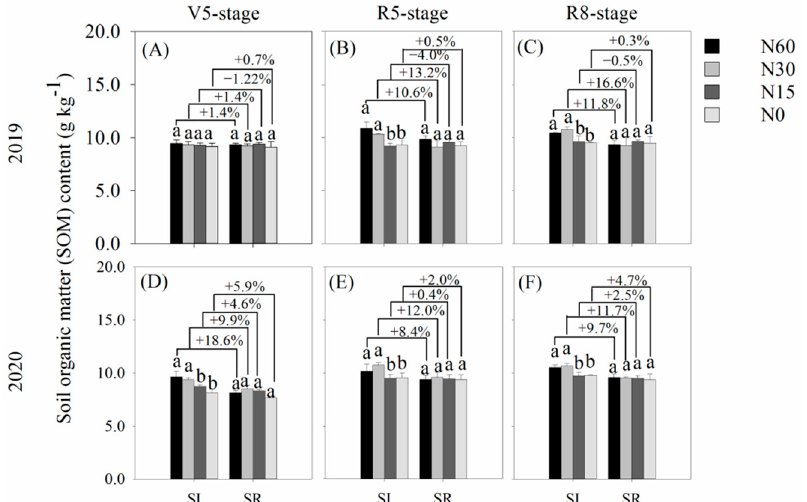
Figure 3. Soil organic matter at the different growth stages of soybean. ( A ) SOM content at the V5 stage of soybean in 2019, ( B ) SOM content at R5 stage of soybean in 2019, ( C ) SOM content at the R8 stage of soybean in 2019, ( D ) SOM content at the V5 stage of soybean in 2020, ( E ) SOM content at R5 stage of soybean in 2020, ( F ) SOM content at the R8 stage of soybean in 2020. In each panel, different lower-case letters “a” and “b” indicate significant differences under different N application rates within the same straw treatment (LSD, p < 0.05). Same lower-case letters indicate no significant differences under different N application rates within the same straw treatment (LSD, p < 0.05). Data were shown as mean ± S.D. ( n = 3). The values indicate the change in SI relative to SR, and “+” and “ − “ indicate increasing and decreasing, respectively. SI, straw incorporation; SR, straw removal; N60, convention N (60 kg N ha − 1 ); N30, reduced N by 50% (30 kg N ha − 1 ); N15, reduced N by